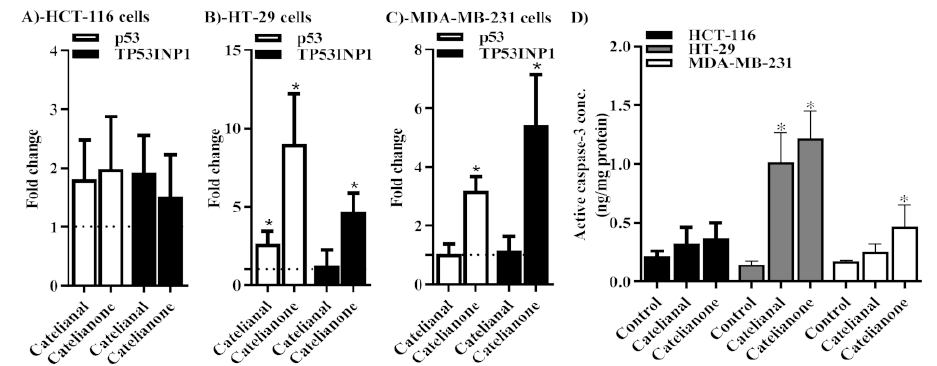
Figure 4. Molecular assessment of apoptosis in after 24 h incubation with Cattleianal and Cattleianone at their IC 50 ’s. The expression of p53 and TP53INP1 genes using qPCR were assessed in HCT-116 ( A ), HT-29 ( B ) and MDA-MB-231 ( C ) cells after 24 h incubation with the IC 50 ’s of cattleianal or cattleianone. The active caspase-3 concentration was assessed in HCT-116, HT-29 and MDA-MB cells using ELISA technique and expressed as ng/mg protein ( D ). Dotted line ( . . . ) in A, B and C panels represent control gene expression equal to one-fold change. * significantly different from control p <